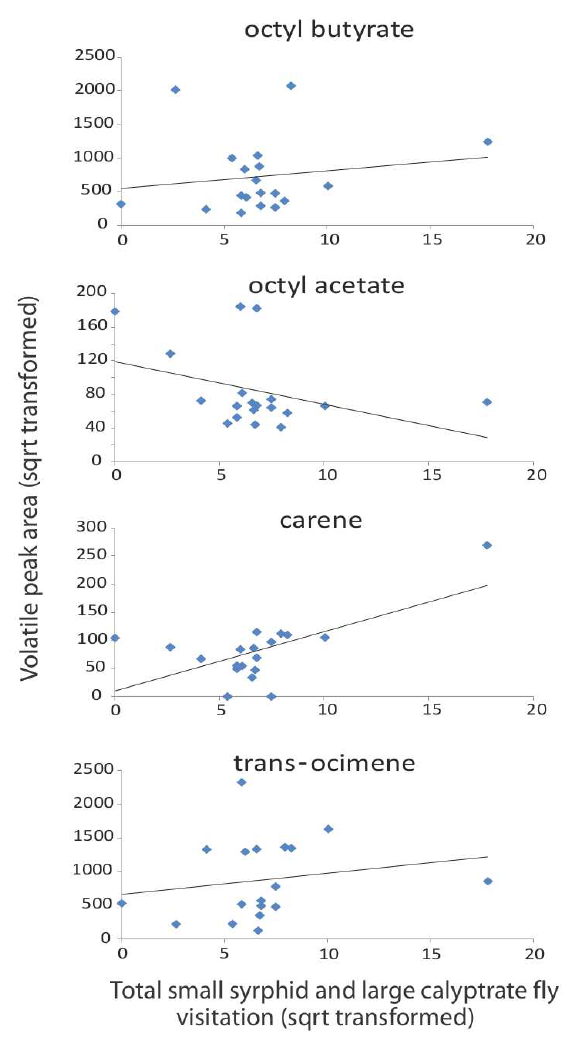
F IGURE 3. Compounds that best explain variation in the NZ pollinator matrix (DISTLM analysis: AICc = 103.95, R 2 = 0.69). Graphs represent the direction of relationship between pollinator visitation (counts of large calyptrate flies and small syrphids) and individual volatile compounds in NZ parsnip